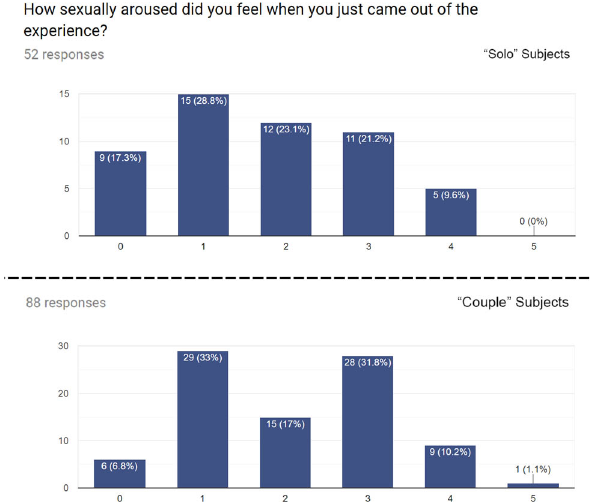
Figure 9: Charts indicating arousal level after the experience in “ Solo ” ( above ) and “ Couple ” ( below ) subjects extracted from the self - report